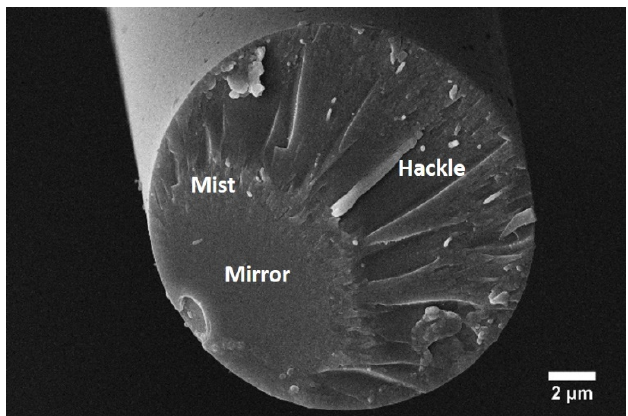
Figure 3. SEM micrograph of fracture surface of a basalt fibre heat treated at 500 °C and in a 3 M NaOH solution for 10 min.